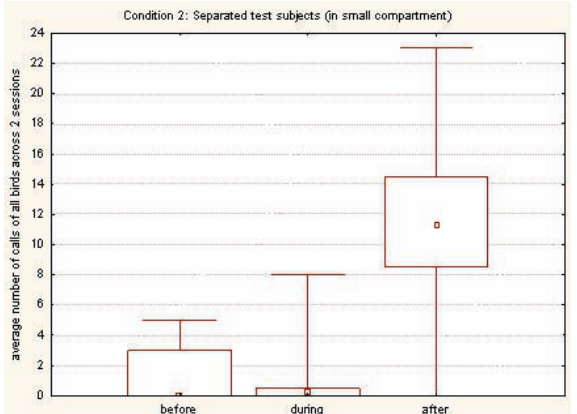
value.Fig. 10. Box and whisker plots for the calls given by the test subjects in the three phases in condition 2. Boxes show the interquartile range; the box for the observers is divided by the median value. Whiskers indicate the largest and smallest value.